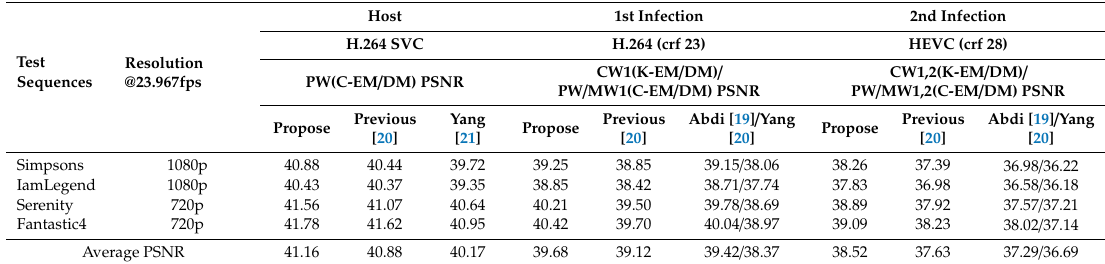
Table 6. PSNR results of pathogen, contagion, and mutant watermarks by H.264 / MPEG4 AVC and HEVC for high